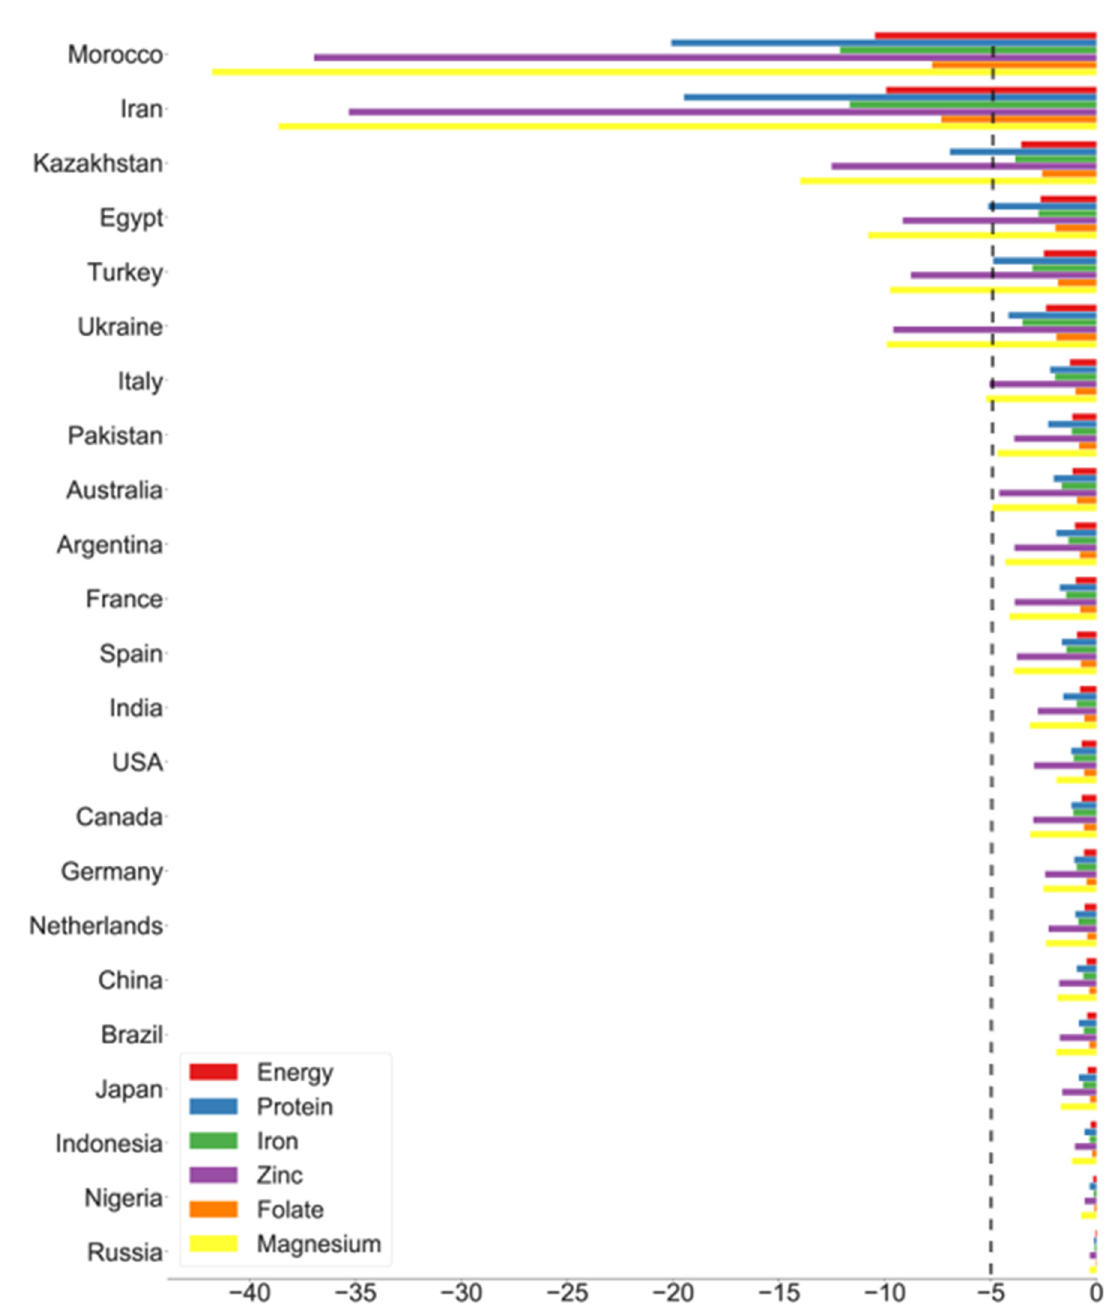
Figure 5. Loss in nutrients (NAR in percentage of daily intake requirements) under the yield shocks + export restrictions scenario (Scenario YQ). Dashed lines highlight the losses above 5% threshold.